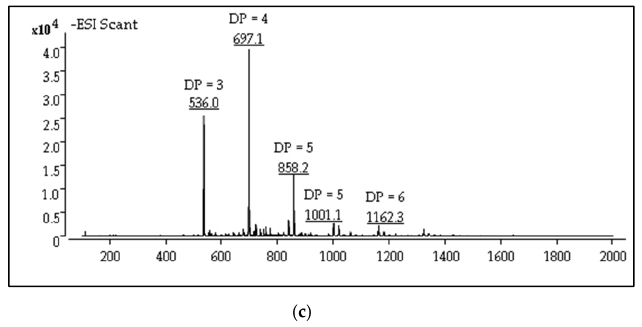
Figure 1. Infrared spectroscopy (IR) spectra ( a ), 1 H nuclear magnetic resonance (NMR) spectra ( b ) and mass spectrum (MS) ( c ).